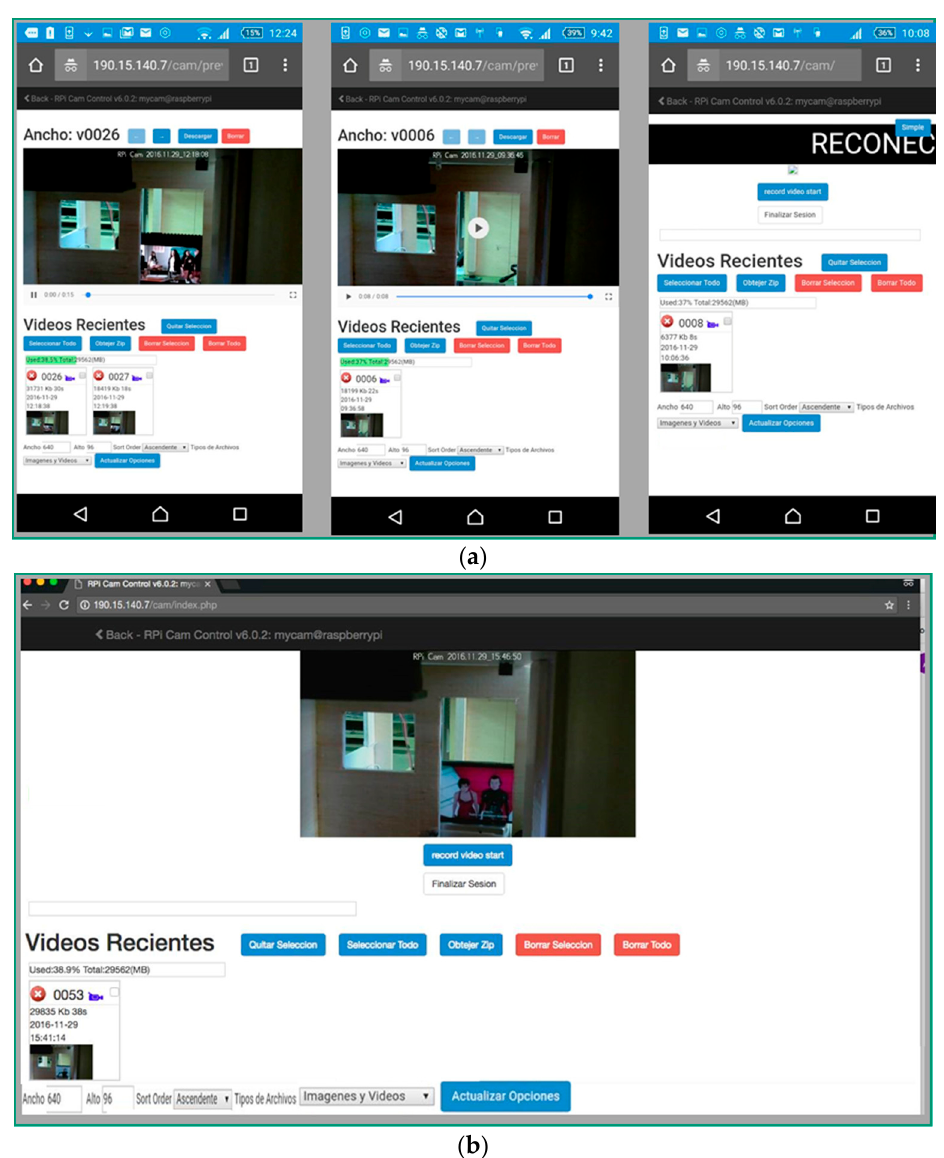
Figure 13. Client interface (in Spanish) of the video surveillance system for the WTerm1 and WTerm 2: ( a ) Three different views for Wterm 1; ( b ) One view for Wterm 2.